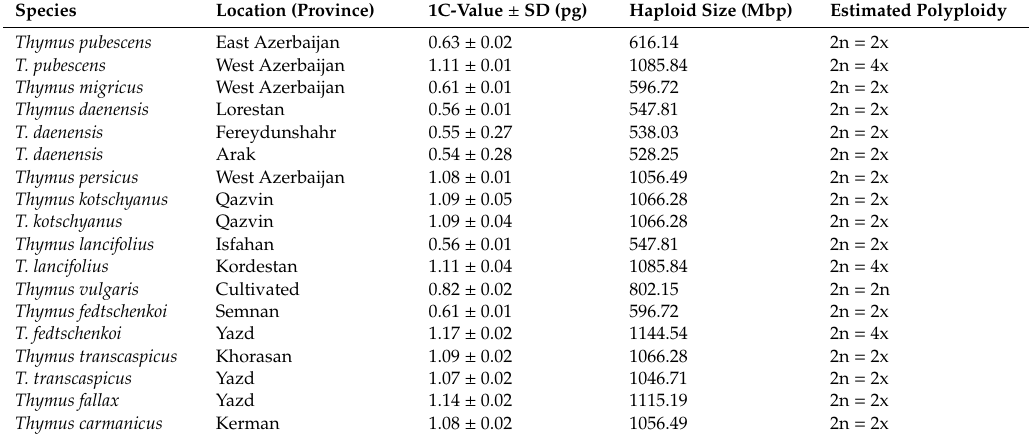
Table 1. Mean (three replicate measurements per plant sample) 2C-value and genome size of Thymus